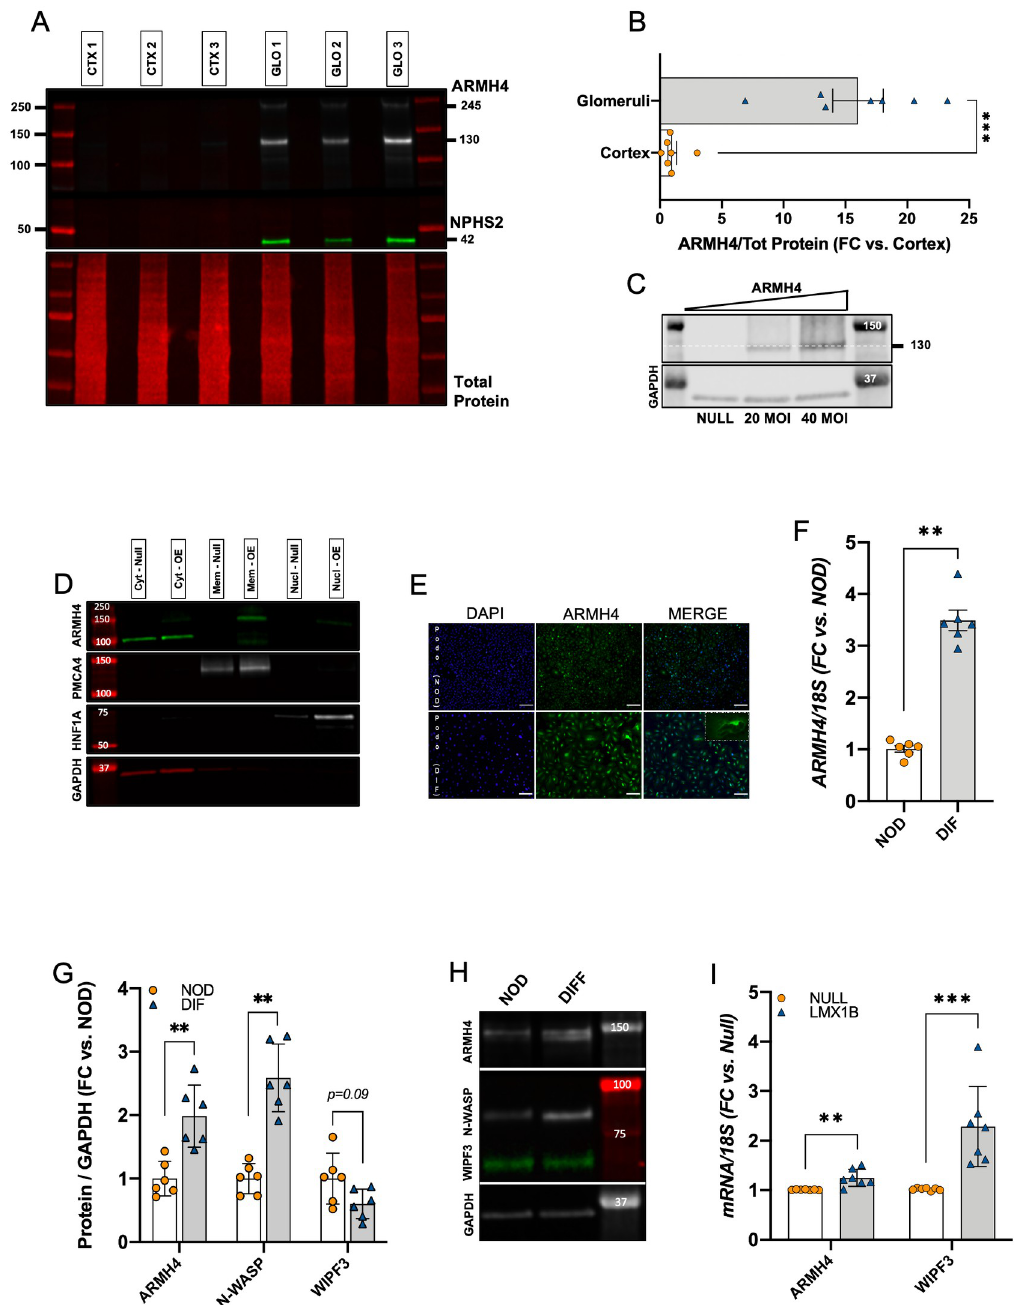
Fig 3. ARMH4 is enriched in isolated human glomeruli, increases in differentiated podocytes, and, like WIPF3, responds to LMX1B. A : representative Western blots from cortices (CTXs) and glomeruli (GLOs) isolated from three patients show higher levels of ARMH4 and NPHS2 in glomeruli compared to cortex. Total protein is shown below. To avoid overlap between lanes in the total protein stain, samples were loaded in every second lane (black lanes = empty wells). B : quantification of ARMH4 protein expression shows fold change (FC) enrichment in the glomeruli relative to cortex. Data was normalized to total protein in the same lane. C : Western blot of protein from tubular epithelial cells (hPTCs) overexpressing ARMH4 shows a major band at 130 kDa that increases in a virus concentration-dependent manner. This result was confirmed in three independent experiments. D : representative Western blots from subcellular fractionation show ARMH4 antibody-reactive bands (green bands) in the cytosolic (Cyt), membrane (Mem) and nuclear (Nucl) fractions in hPTCs overexpressing ARMH4 (OE) compared to Null. Overexpression of ARMH4 increases a 130 kDa band in the membrane fraction. A 100 kDa band in the cytosolic fraction does not respond to overexpression, suggesting unspecific binding. This analysis was repeated twice using